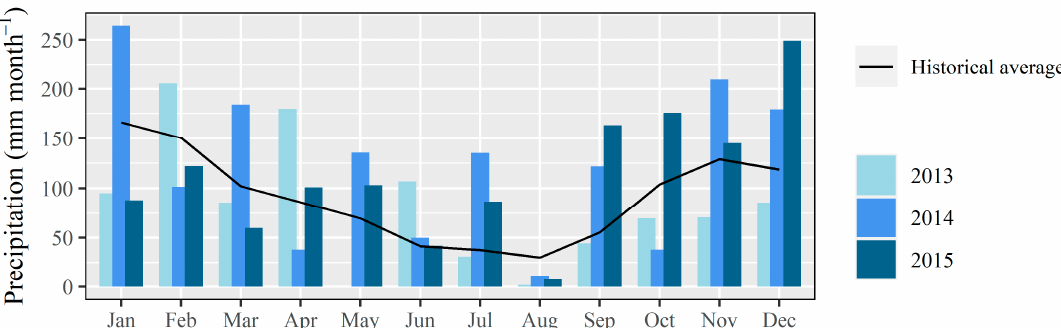
Figure 7. Monthly rainfall for the years 2013, 2014, 2015, and the historical average for the region of Maracaj ú , MS, Brazil. Data source: Automatic weather station A731-INMET, 2020.